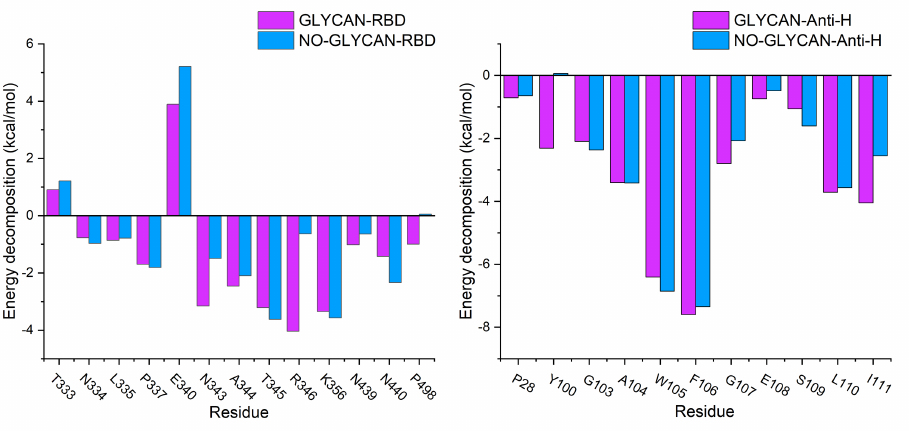
Figure 3. Free energy decomposition of key residues. Purple column is GLYCAN; blue column is NO-GLYCAN.